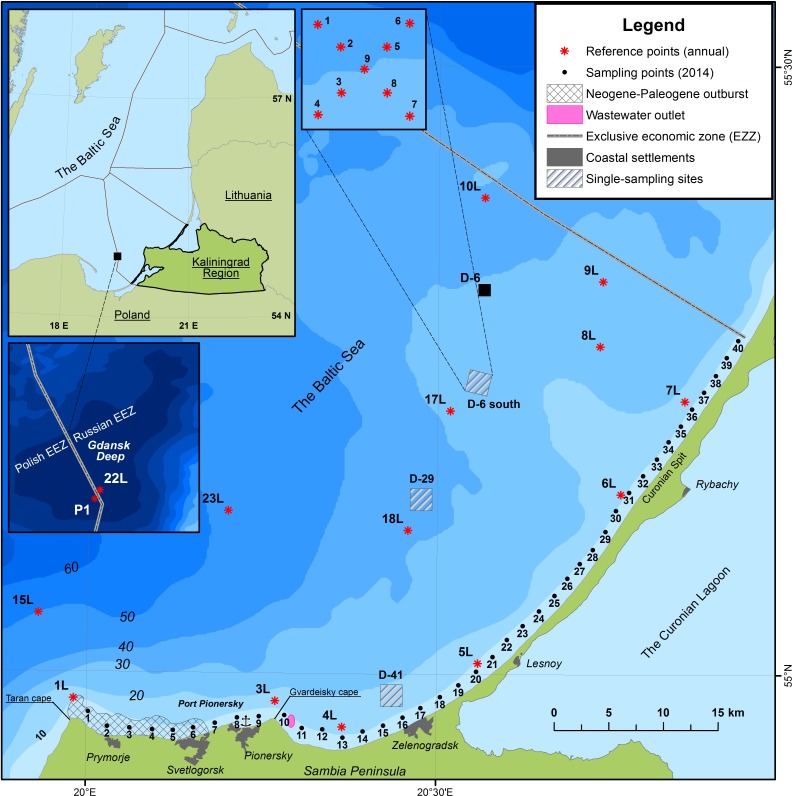
Initial data map.